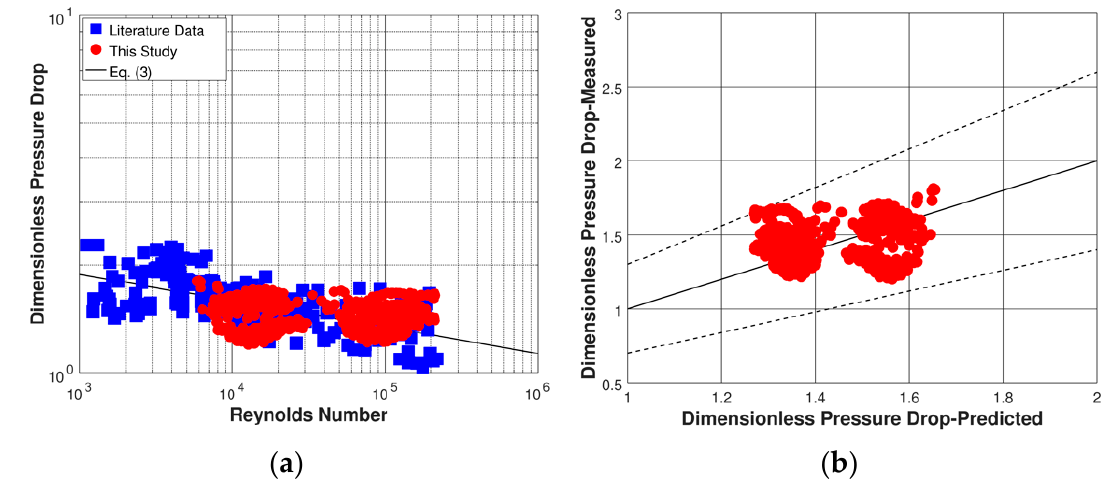
Figure 5. ( a ) Dimensionless pressure drop as a function of Reynolds number for the micro-orifices tested in this study and from the literature; ( b ) parity plot of measured dimensionless pressure drop vs. prediction of Equation (3) (the dashed lines are ±30% bounds).